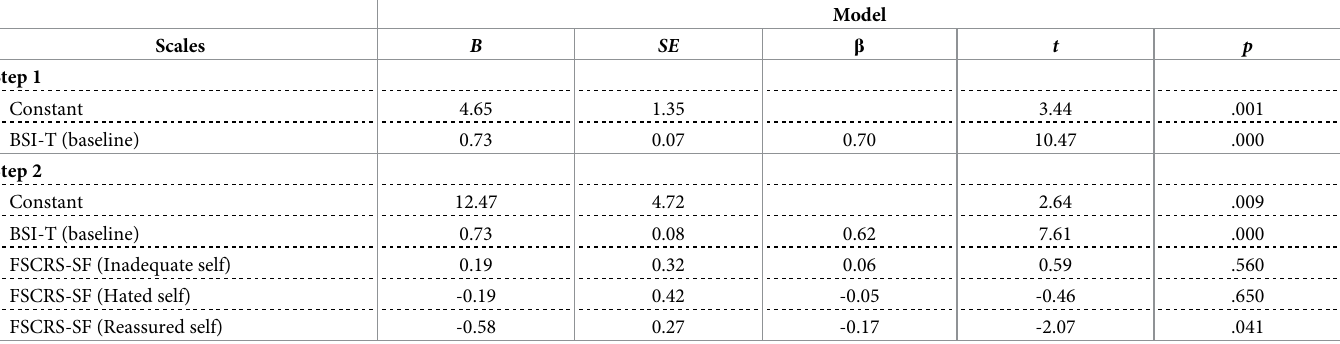
Table 6. Hierarchical regression results for global index of general distress at three months’